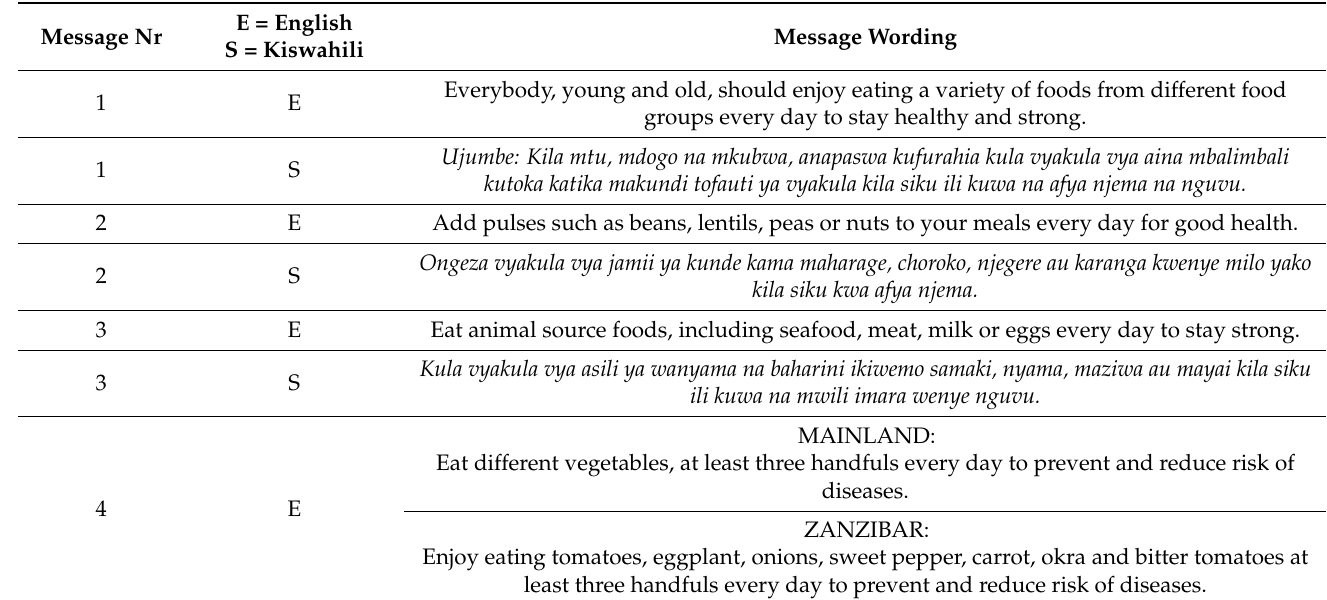
Table 1. DRAFT FBDG messages for field-testing with the population of Tanzania. Message Nr Message